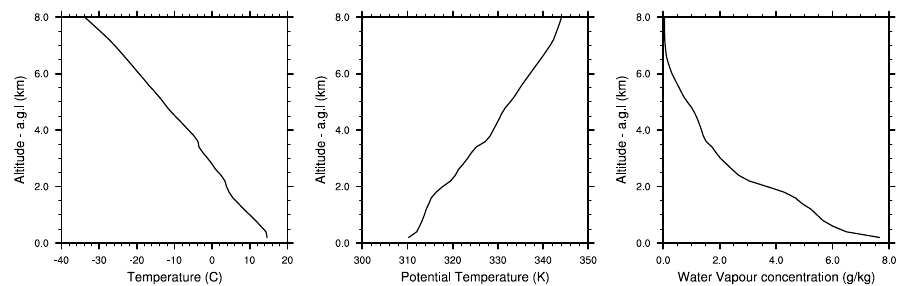
Figure 5. Meteorological profiles from the 3-D spin-up model (1km resolution) at the location of the January 2010 summit eruption on 2 January 2010 at 10:50UTC. Vertical profiles of temperature ( ◦ C), potential temperature (K) and water vapour mixing ratio at the grid scale (gkg − 1 ). Altitude displayed is above ground level (a.g.l.), which is at 2600ma . s . l .